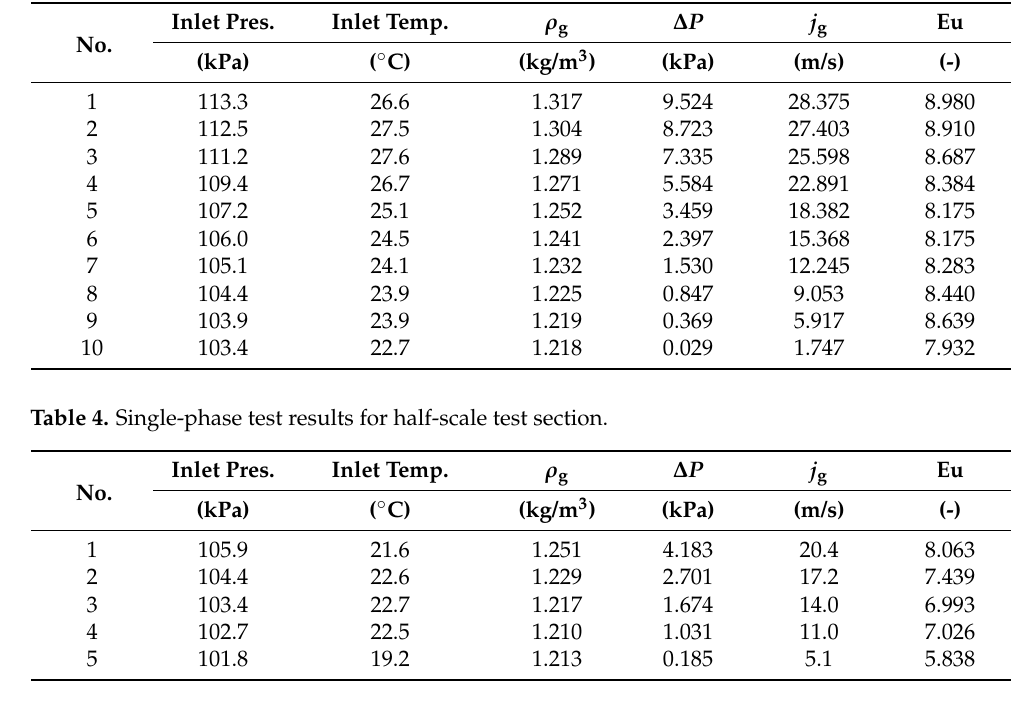
Table 3. Single-phase test results for full-scale test section.